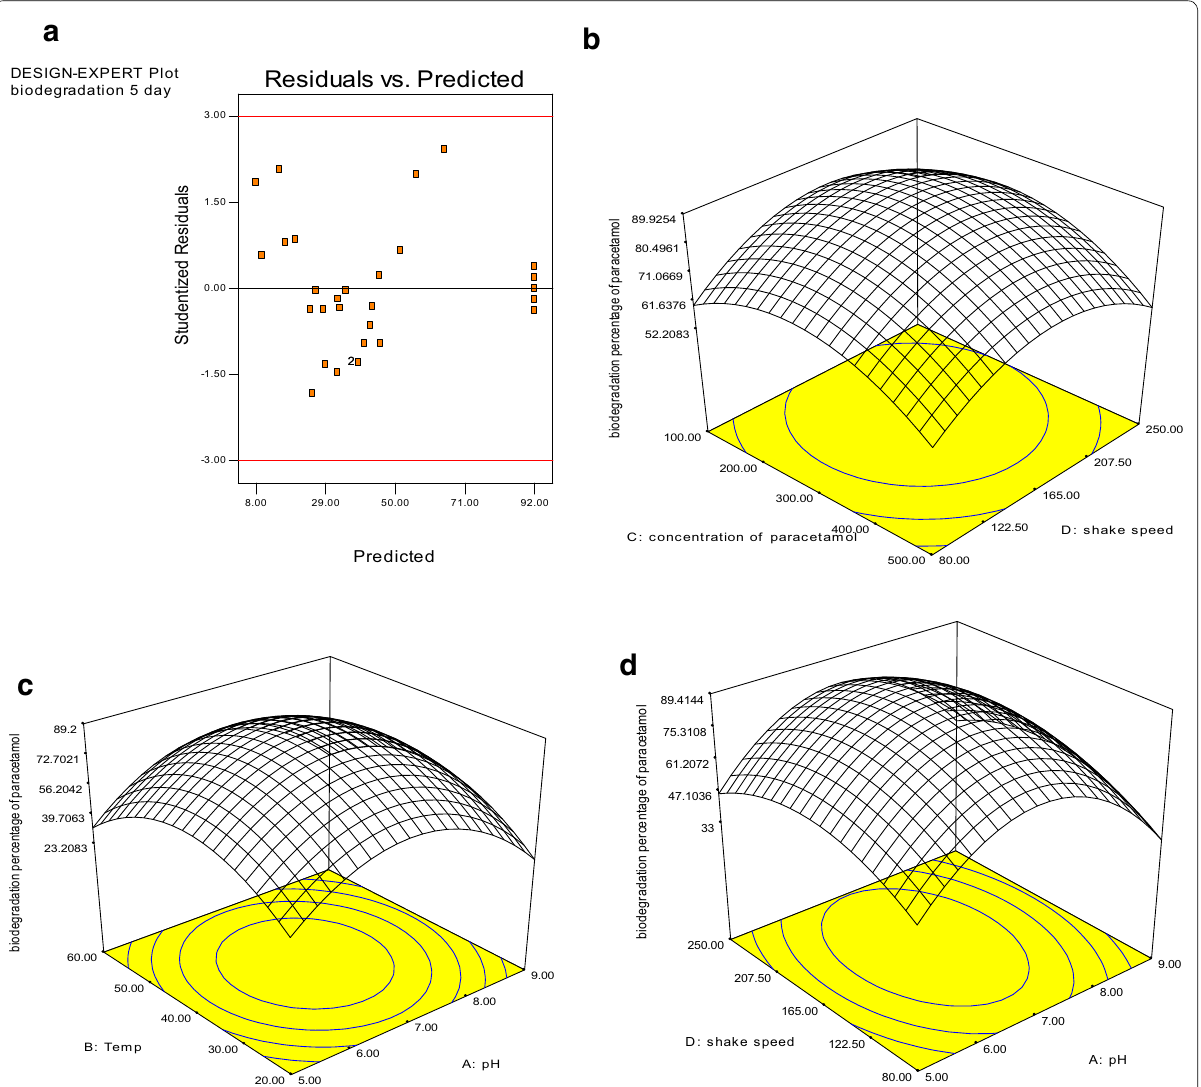
Fig. 2 Parity plot and 3D plots of RSM showing optimization study of degradation of APAP by strain S1 under different physiological conditions. a Parity plot showing distribution of experimental and predicted values of APAP; b 3D-RSM plot showing the effect of concentration of APAP vs. shake speed; c 3D RSM plot showing the effect of temperature vs. pH; d 3D- RSM plot showing the effect of shaking speed vs.